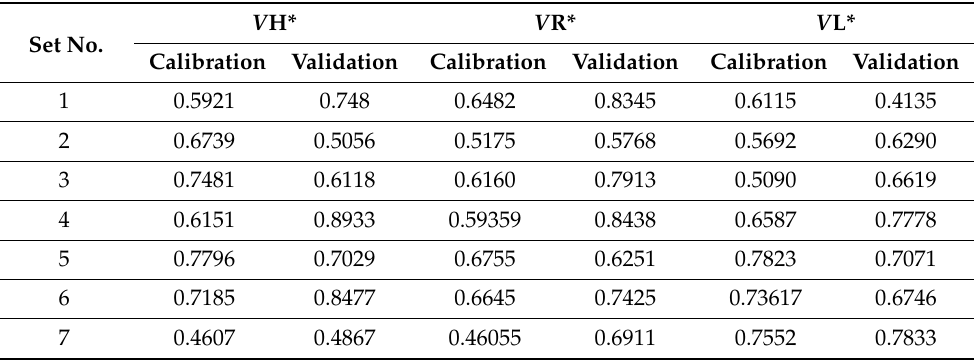
Table 3. Correlations of GEP performance in the calibration and validation stage for 3D scour rates. Set